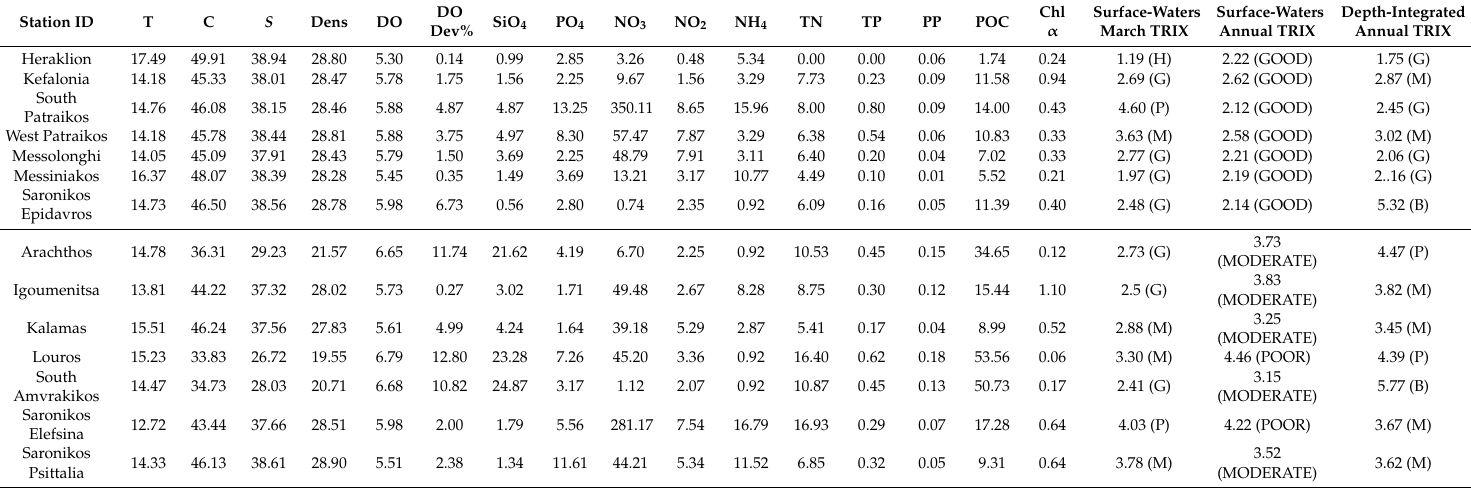
Table 1. Abiotic variables. Temperature (T, o C), conductivity (C, mS cm 1 ), salinity ( S , psu), density (Dens, kg m − 3 ) and the concentrations of dissolved oxygen (DO, mmole L − 1 ), DO (% DO Dev), silicate (SiO 4 , µ M), phosphate (PO 4 , µ g L − 1 ), nitrate (NO 3 , µ g L − 1 ), nitrite (NO 2 , µ g L − 1 ), ammonium (NH 4 , µ g L − 1 ), total nitrogen (TN, µ M), total phosphorus (TP, µ M), particulate phosphorus (PP, µ M), particulate organic carbon (POC, µ M), and chlorophyll α (Chl α , µ g L − 1 ), along with the resulting TRIX (surface-waters March TRIX values and categories). The annual surface TRIX (surface-waters annual TRIX values and categories) are presented in capital letters and were used for the grouping of the sampling stations in this study. The depth-integrated annual TRIX is also presented in the last column for comparison with the surface